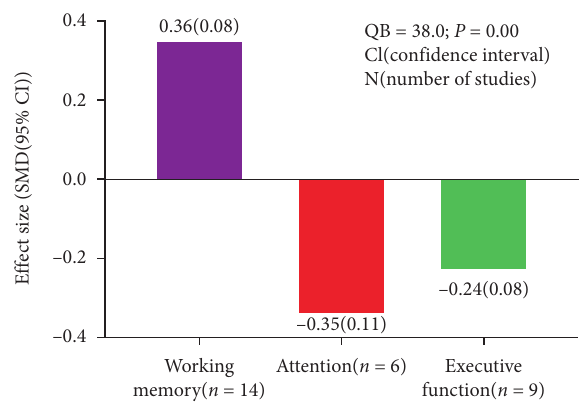
Figure 5: Mean effect of PA on cognitive domain. Significant difference ( P < 0 . 05) was observed between three domains.